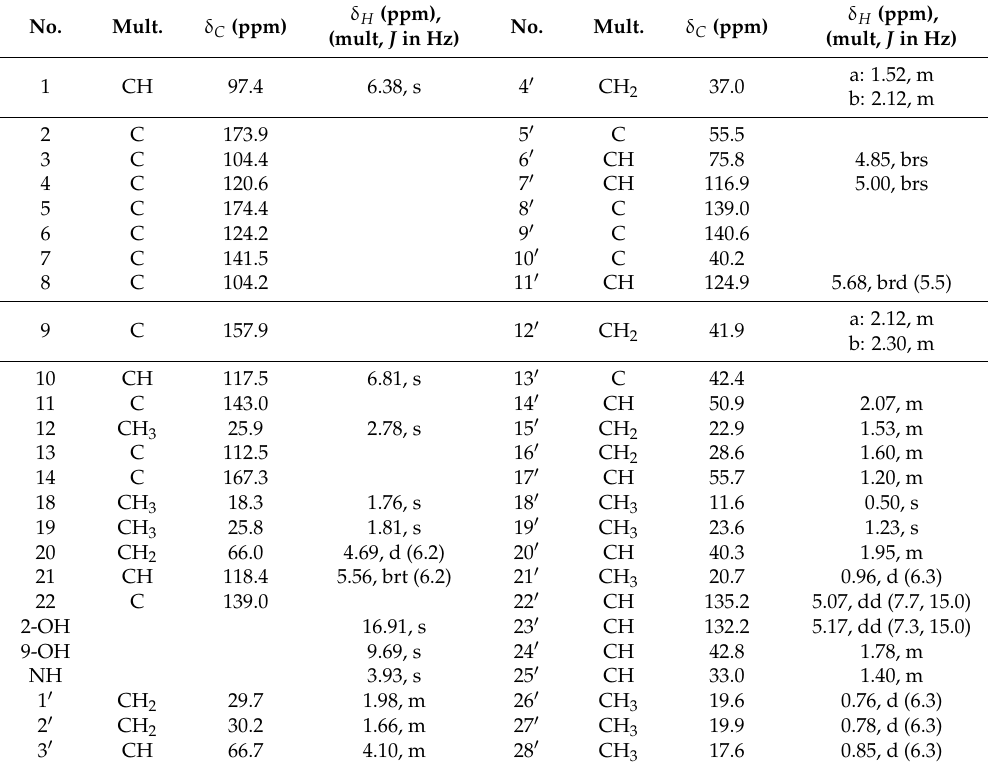
Table 1. NMR (CDCl 3 ) spectroscopic data for conio-azasterol ( 1